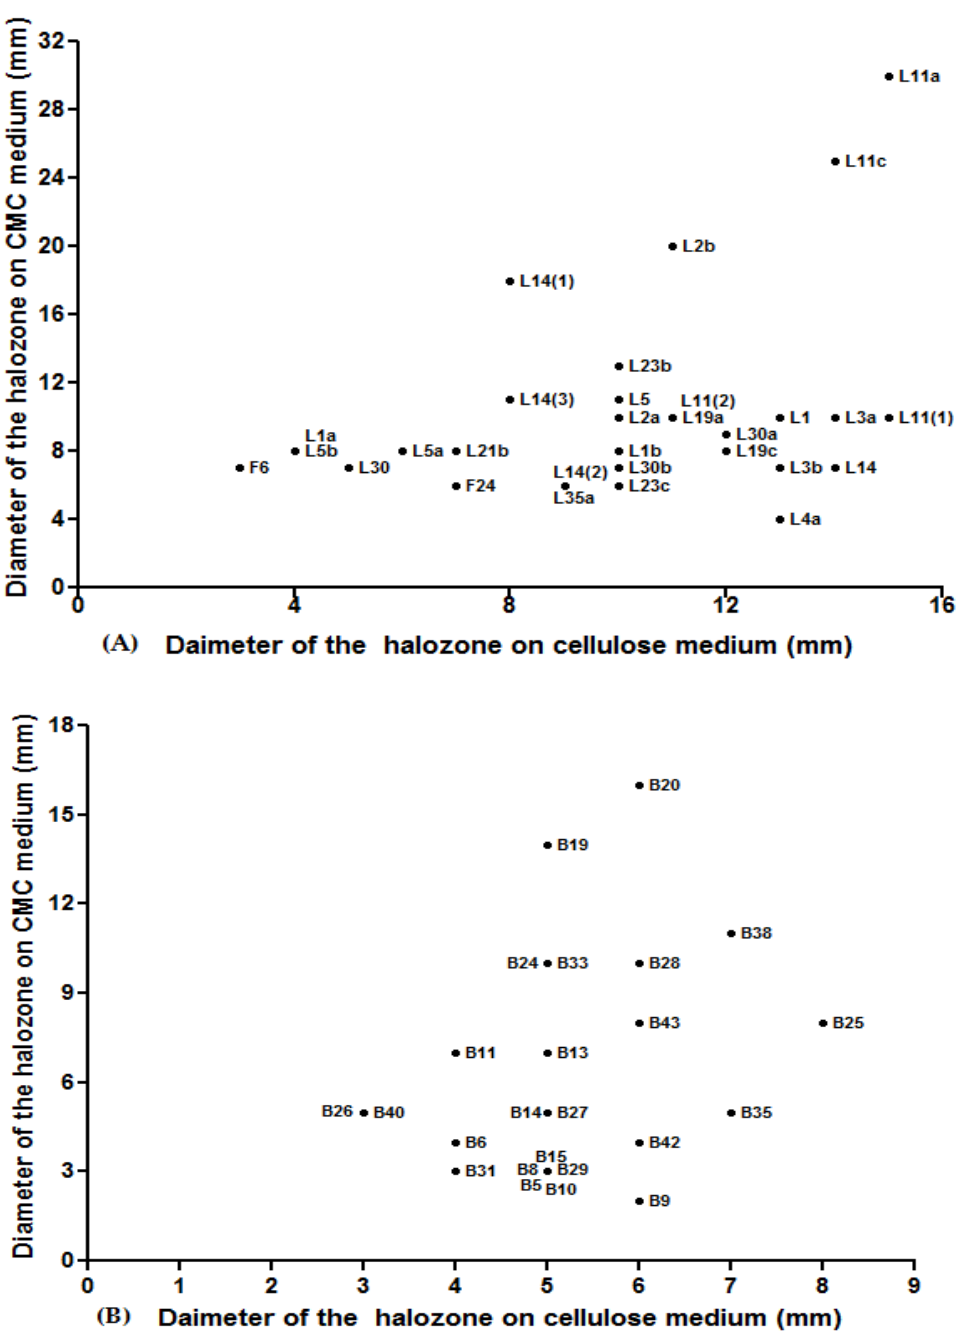
Figure 1. Screening of cellulase activities carried out for the strains isolated ( A ) from the gut of Gymnopleurus Sturmi (GGS), ( B ) and from the dung of ruminants (DR).